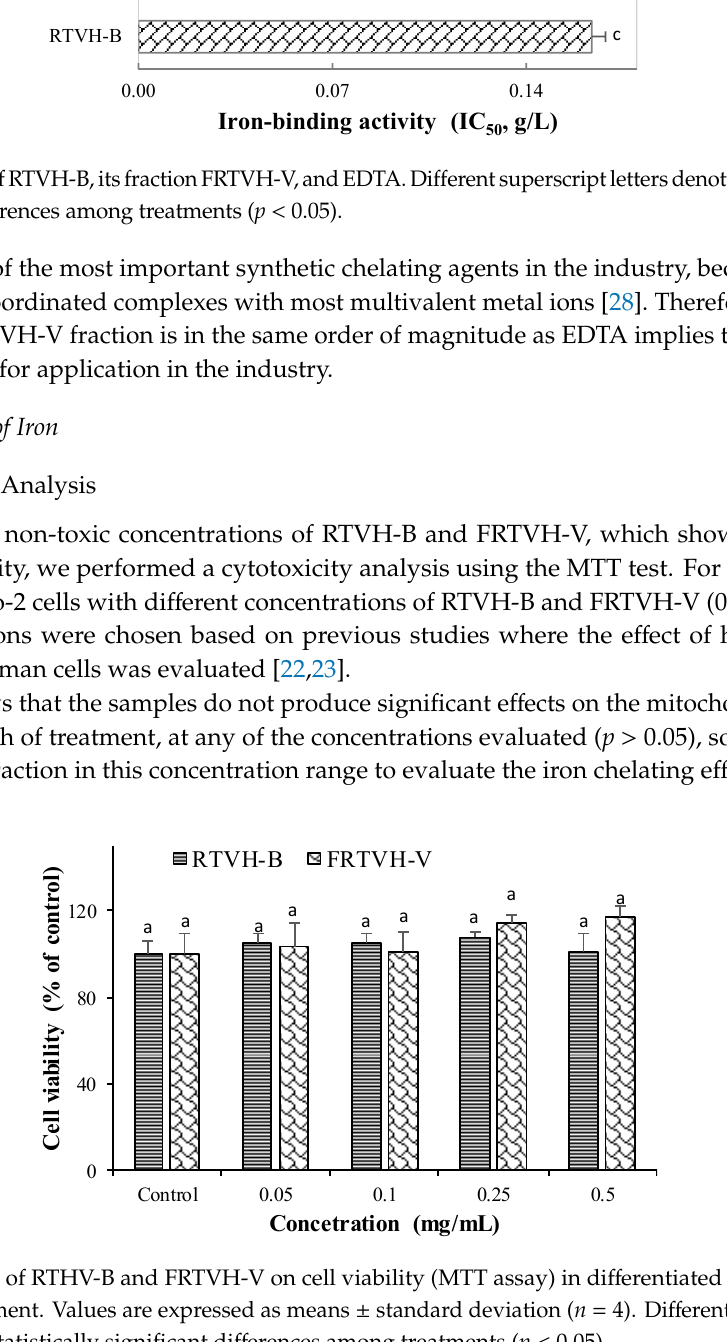
Figure 3. Iron-binding activity of RTVH-B and its molecular weight fractions. Values are expressed as means ± standard deviation ( n = 4). Different superscript letters (a–d) denote statistically significant differences among treatments ( p < 0.05).